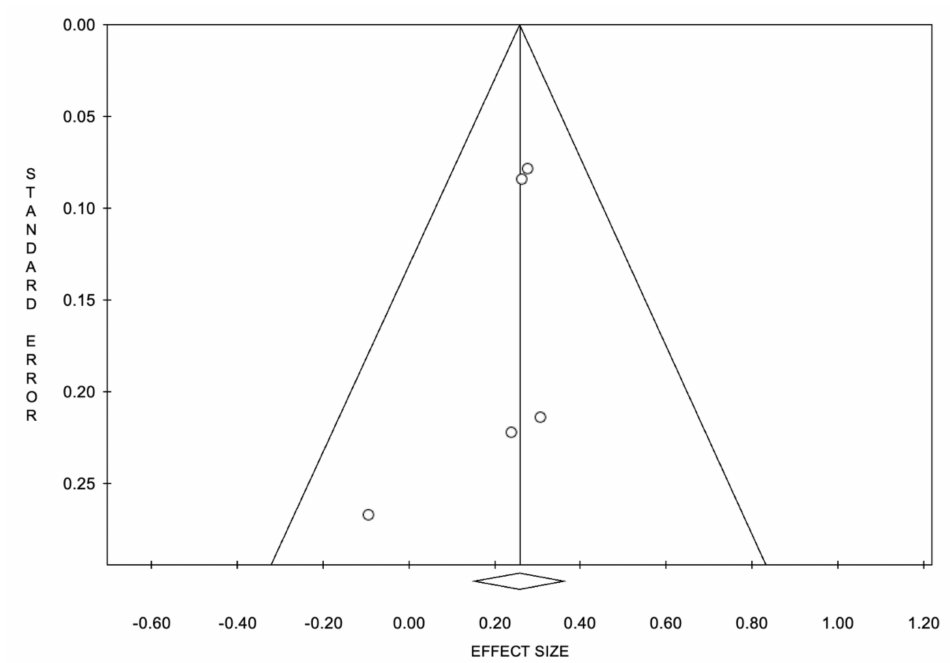
Figure 5. Funnel plot of progression-free